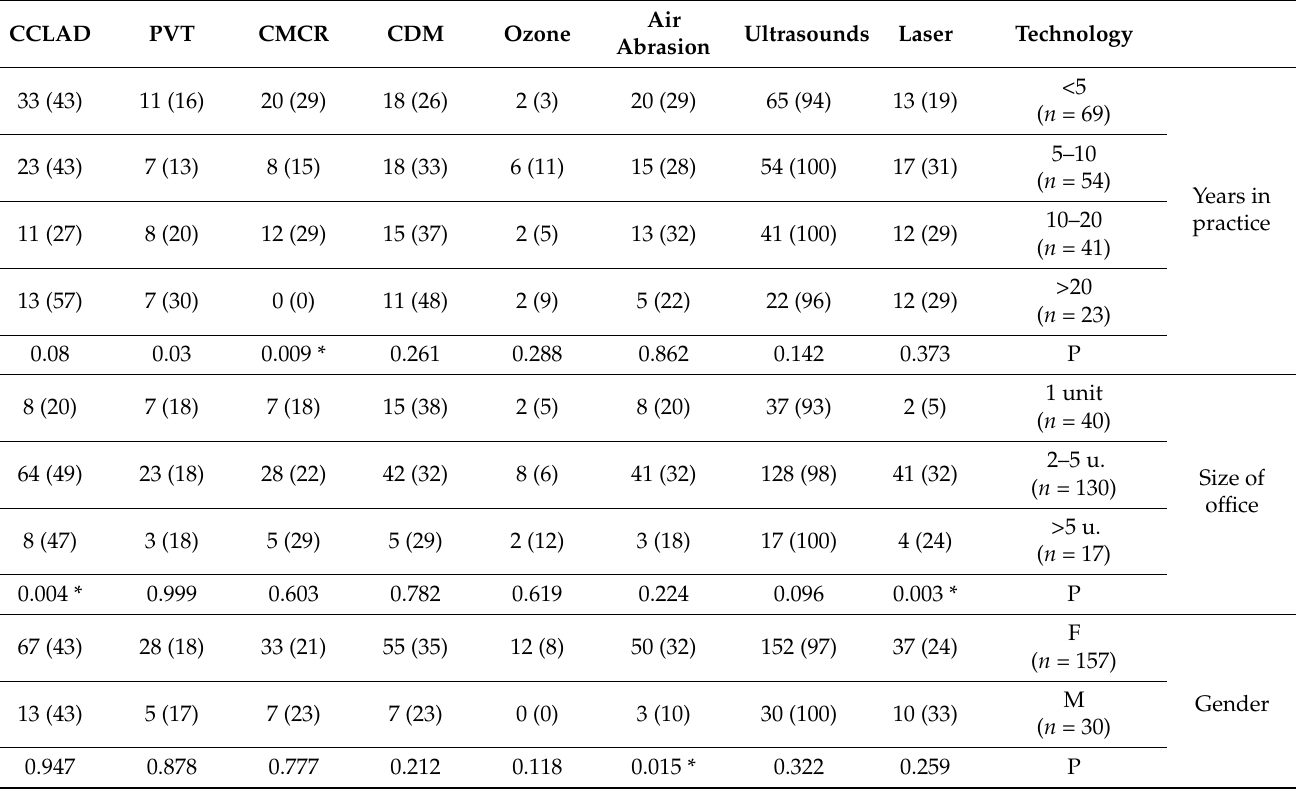
Table 3. The number of respondents (percentage) who use each